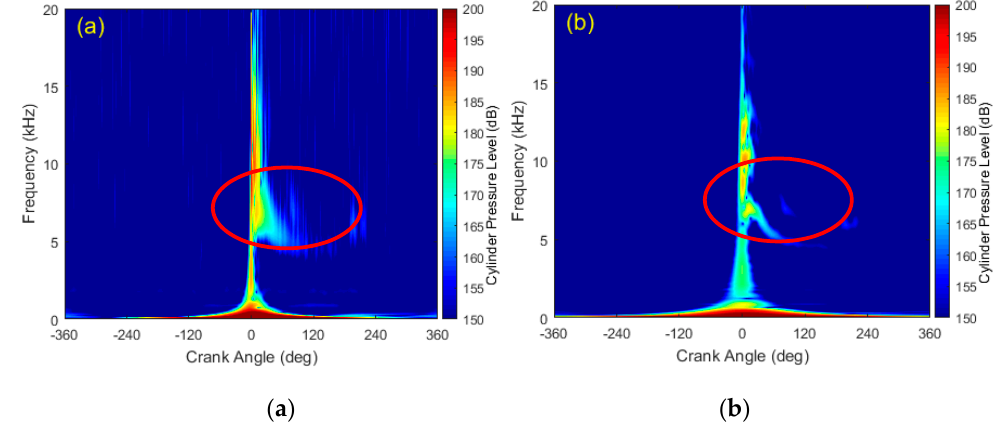
Figure 2. Time-frequency distribution (TFD) of the in-cylinder pressure under 1400 r/min full load condition: ( a ) TFD results of generalized S transform ( GST ); ( b ) TFD results of adaptive generalized S transform ( AGST).